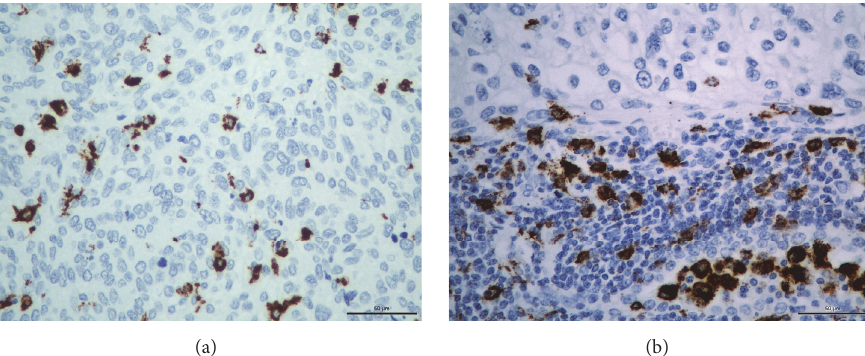
Figure 3: Photomicrographs of CD-68 immunohistochemical expression in IICs in non-small-cells lung cancer (magnification/scale bar: 400x/50 𝜇 ). (a) Isolated IICs in a tumor area. (b) Positive CD-68 expression in a cluster of inflammatory